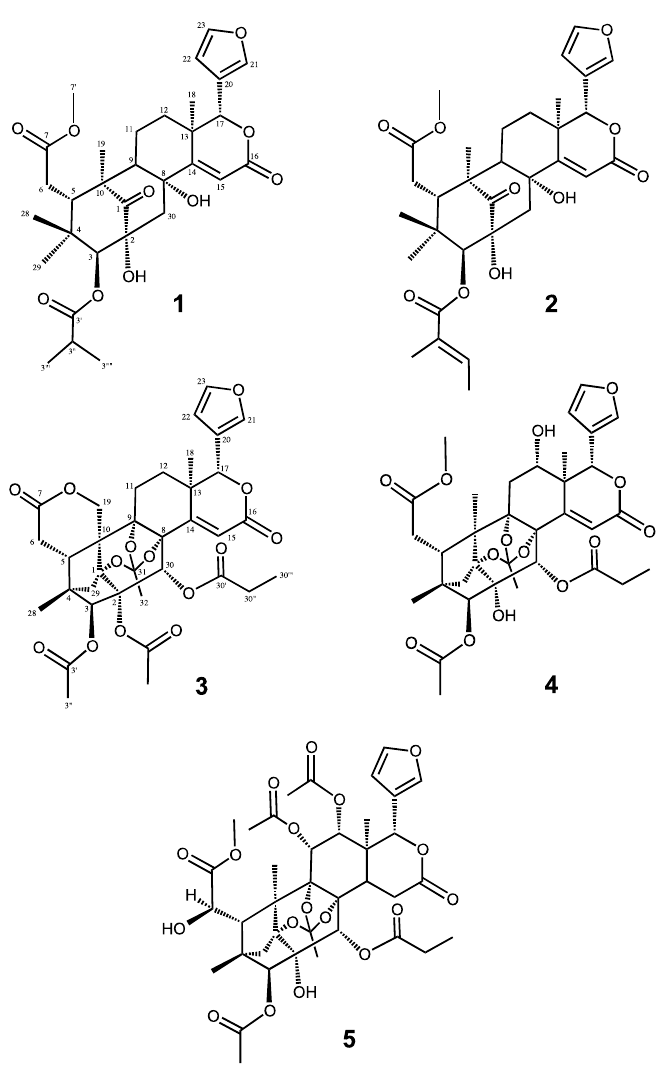
Figure 1. Chemical structures of Compounds 1 – 5 .